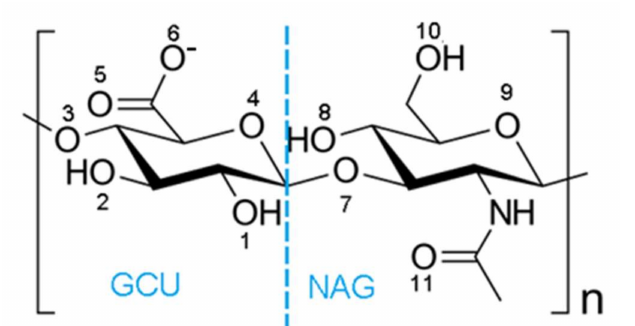
Figure 1. Structure of the repeating disaccharide unit of hyaluronate, the deprotonated form of hyaluronic acid. GCU stands for D-glucuronic acid with pKa of about 3, and NAG means N-acetyl- D-glucosamine. The different oxygen atoms are numbered, and this numbering will be utilized when discussing the interaction with human serum albumin.